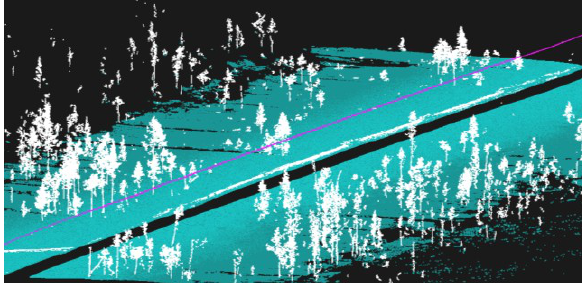
Figure 5. Snow surface classification of MLS